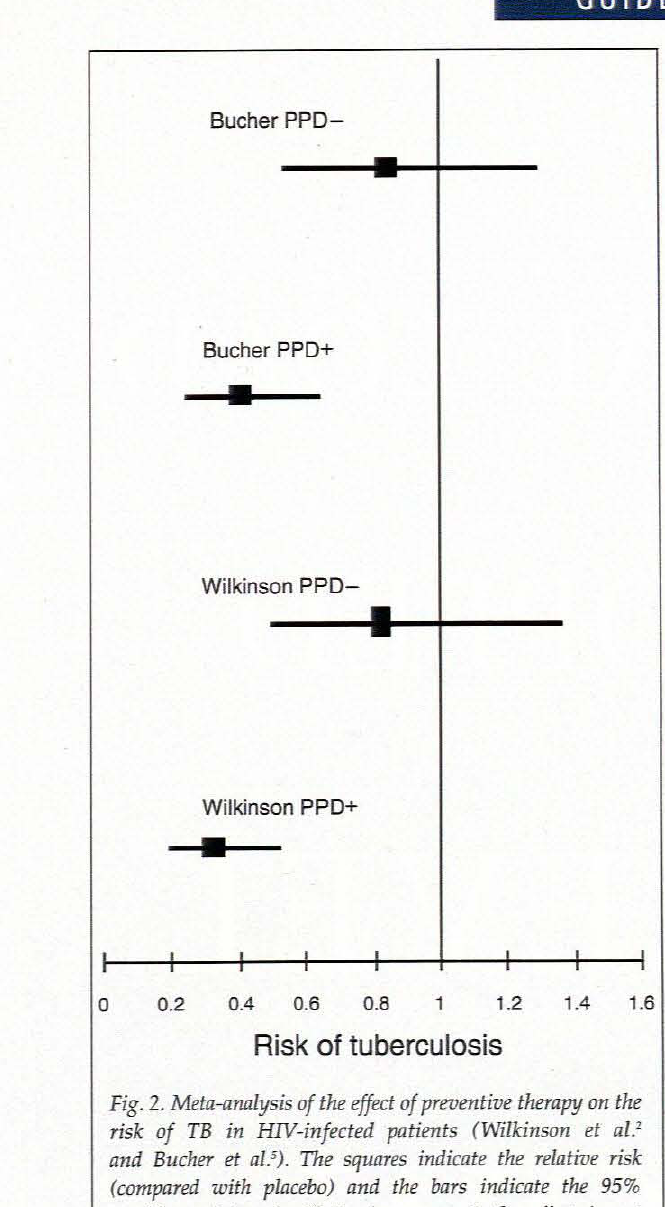
Fig. 2. Meta~nalysis of the effr:ct ofpreventive therapy on the risk of TB in HW-infected patients (Wilkinson et uP and Rucher et uP). The squares indicate the relative risk (compared with placebo) and the bars indicate the 95% confidence interoals. If the bars cross 1 the effect is not statistically significant. PPD indicates the hlberculin (or purified protein derivative) skin test result - positive is ;? 5 mm induration using the Mantoux.